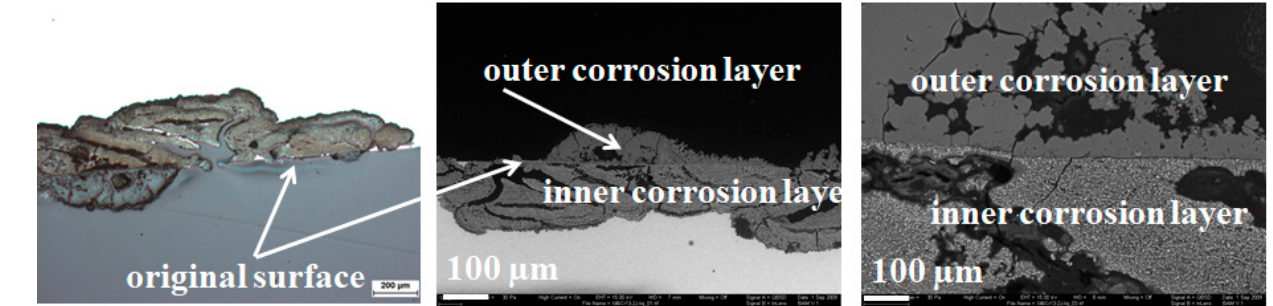
Figure 6. SEM micrographs of X46Cr13 after 17,200 h of exposure at 60 °C and 100 bar to water saturated supercritical CO 2 clearly showing the inner and outer corrosion layer.